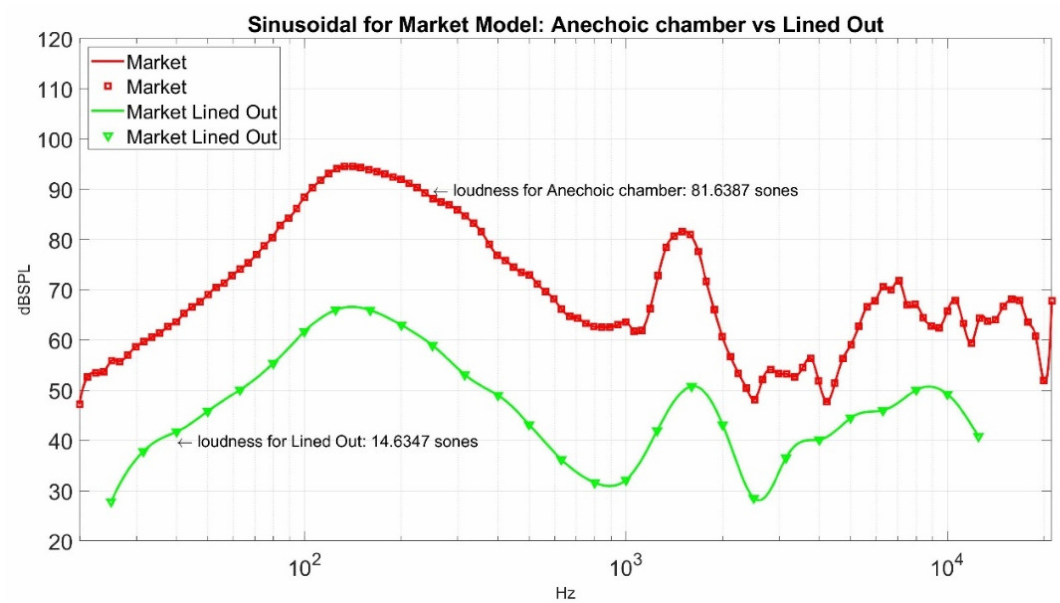
Figure 17. The sound pressure level curves for muffler in the market.